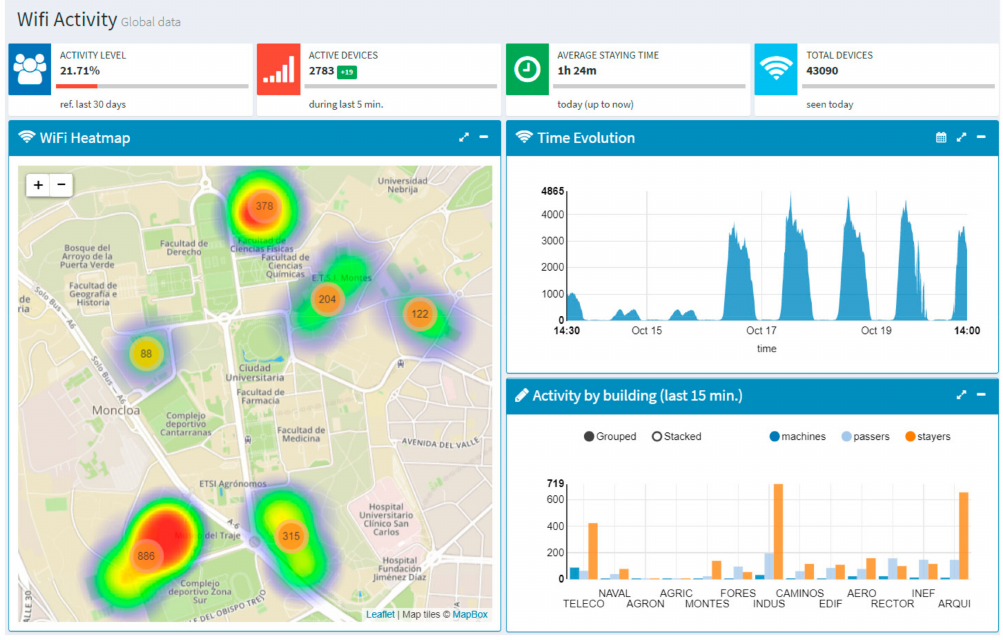
Figure 10. Welcome page of the Smart CEI Moncloa dashboard.